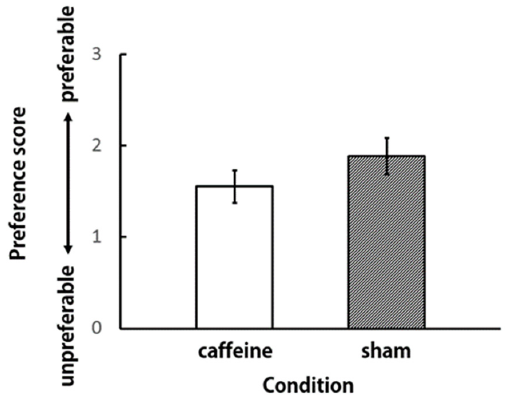
Figure 3. Preference score for the aroma of vapors ( N = 9).